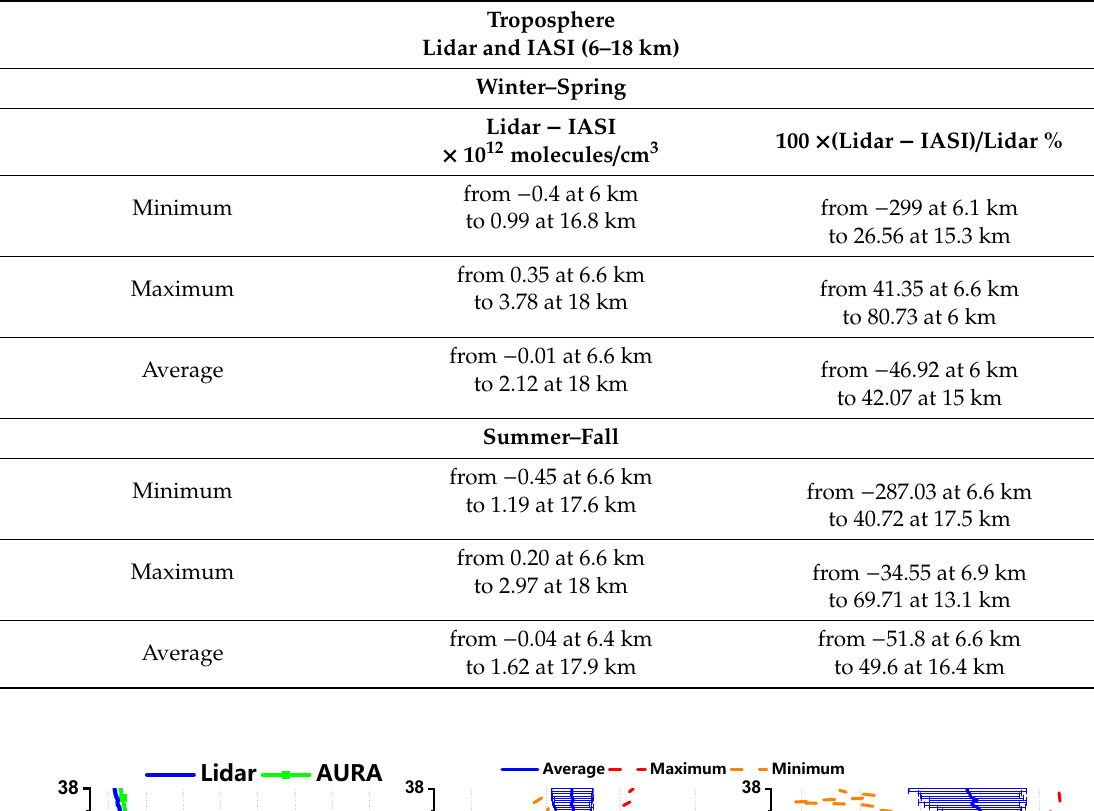
Table 5. Comparison of lidar and IASI satellite data for two seasons: winter-spring and summer-fall.